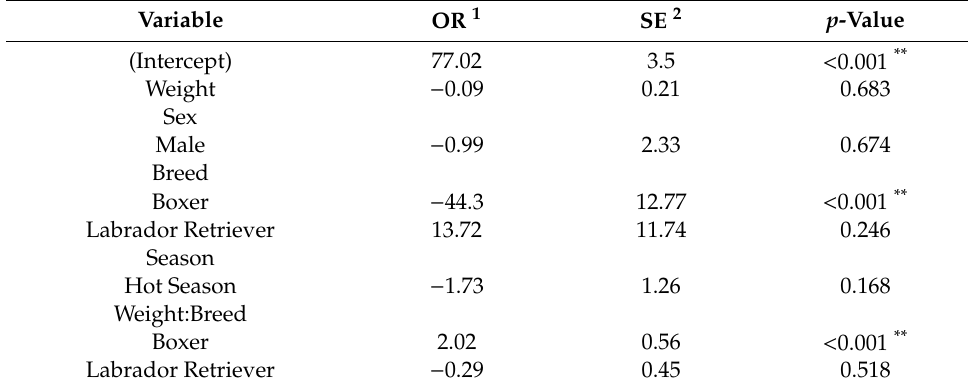
Table 5. Odds ratio and associated statistics of fixed e ff ects included in the final preference model.